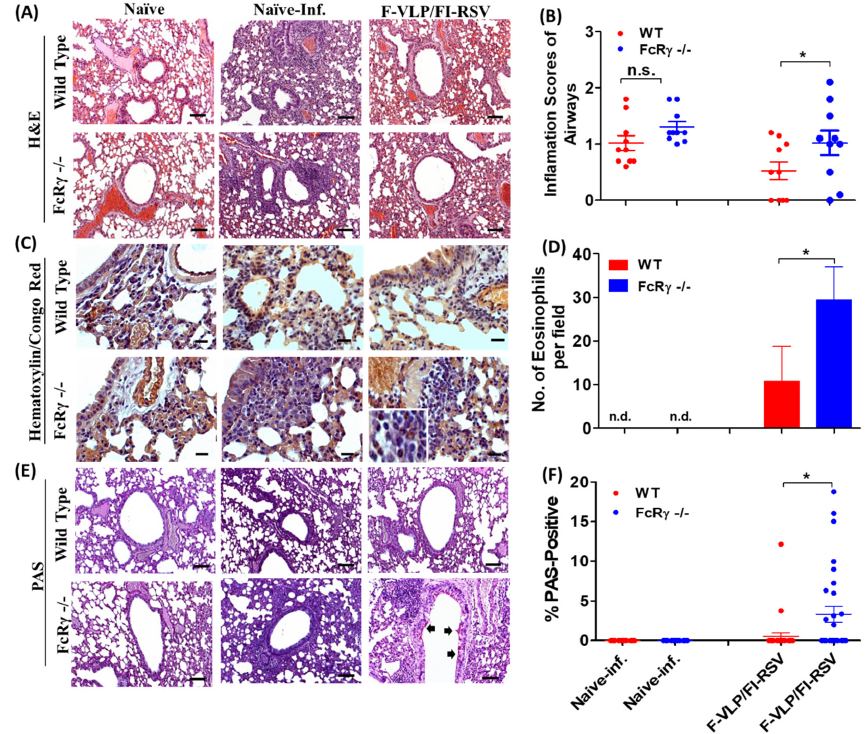
Figure 6. Lung histopathology, eosinophilic infiltration, and mucus production of lungs in WT and FcR γ − / − mice after RSV challenge (n = 5 per group). ( A ) H&E staining of